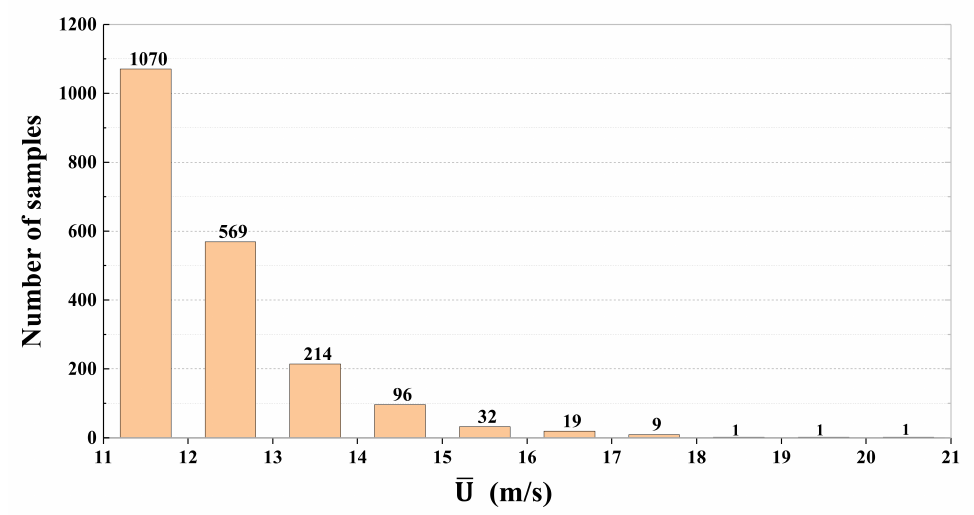
Figure 4. The distribution of the intense wind records with the 10-min mean wind speed detected by the 140 m